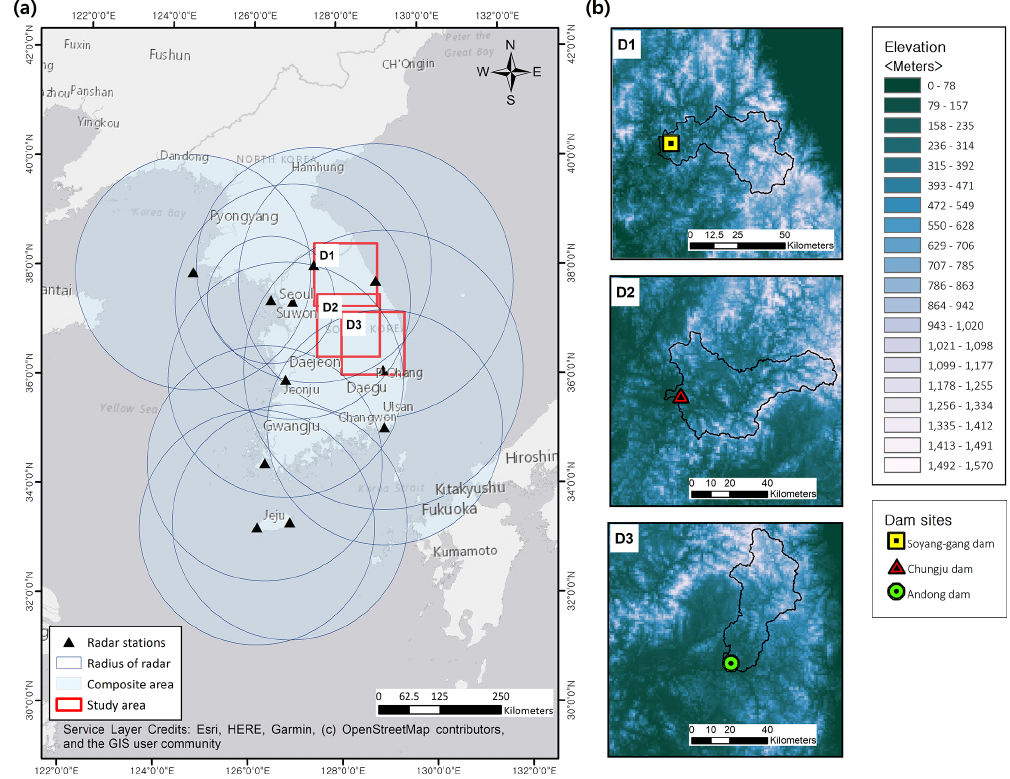
Figure 1. (a) Composite map of radar reflectivity and location of the dam basins; (b) selected areas over the dam basin. D1, D2, and D3 represent the areas of the Soyang-gang, Chungju, and Andong dam basins respectively. Maps were created using ArcGIS software by Esri; Base-map source: Esri, HERE, Garmin, © OpenStreetMap contributors, and the GIS User